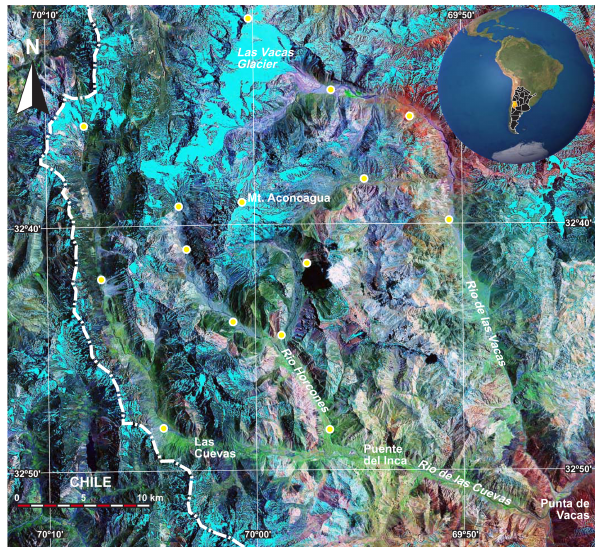
Fig. 1. Location of the study area. Locations of GCPs are shown as yellow dots.